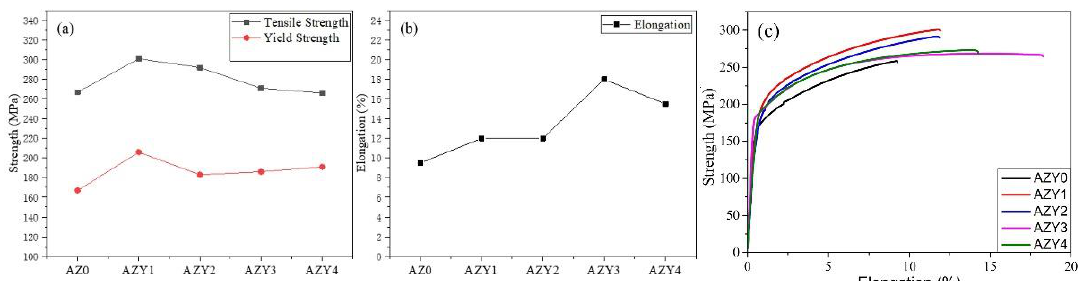
Figure 7. Mechanical properties of the rolled sheets with different Y contents: ( a ) tensile strength and yield strength of sheets; ( b ) elongation of sheets; and ( c ) stress – strain curve. Figure 8 is the tensile fracture morphology of the rolled sheets with different Y contents.